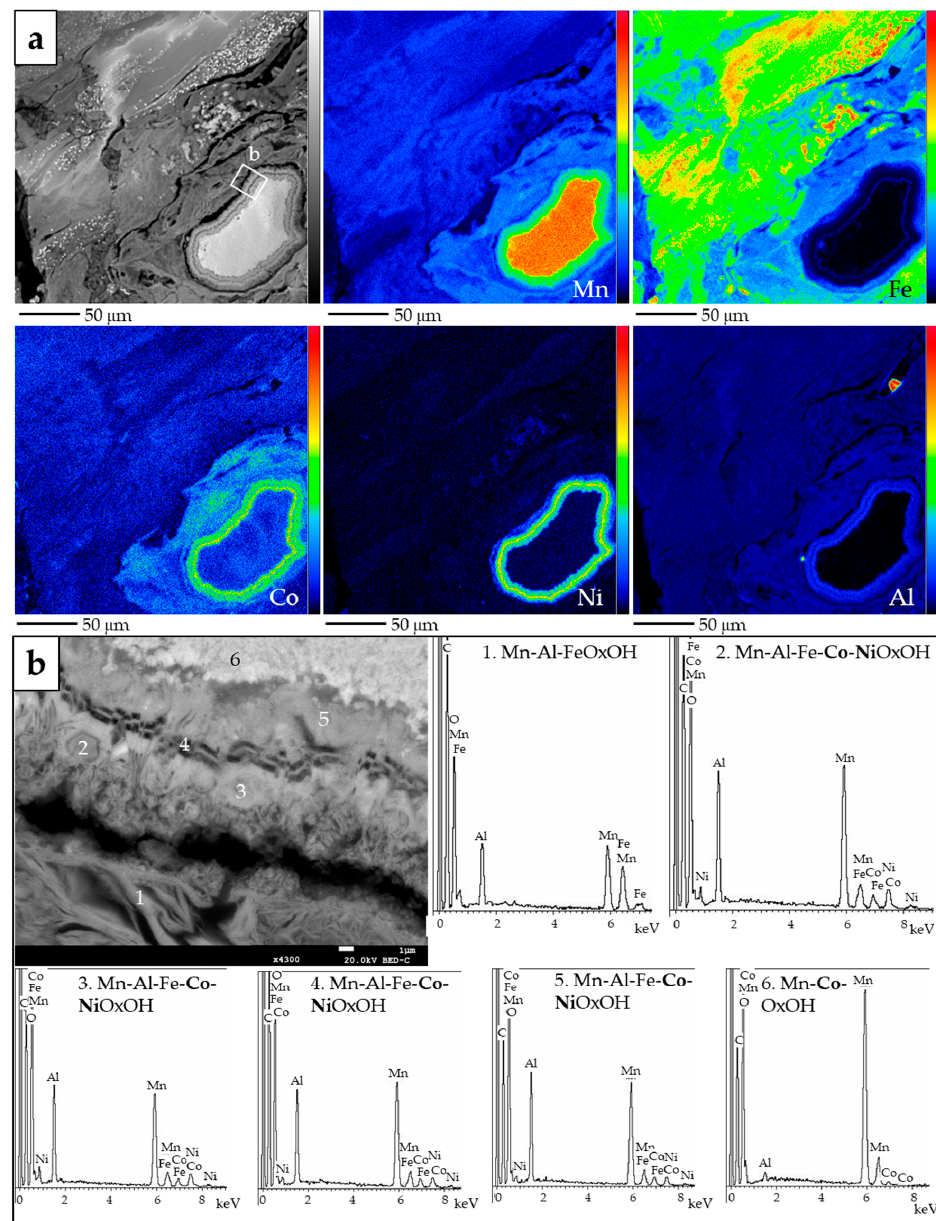
Figure 10. ( a ) BSE photomicrograph (top left) and Mn, Fe, Co, Ni and Al X-ray elemental maps obtained by EMPA, of the same sub-rounded multi-phase Mn-oxyhydroxide grain in Figure 9c (Loma de Hierro), in a matrix of Mn- and Fe-oxyhydroxides (colour scale from black to red indicates increasing element content); ( b ) magnified image of the outer rim of the same grain, displaying variations in composition in terms of Mn, Al, Fe, Ni and Co. The second type, less common, were short fibres of a few tens of micrometres in length, in close association with Fe-oxide and within serpentine veinlets (Figure 9e). Finally, the least common Mn-oxyhydroxide in Loma de Hierro occurred as frag- mented tabular aggregates, dispersed in the goethite matrix (Figure 9f).